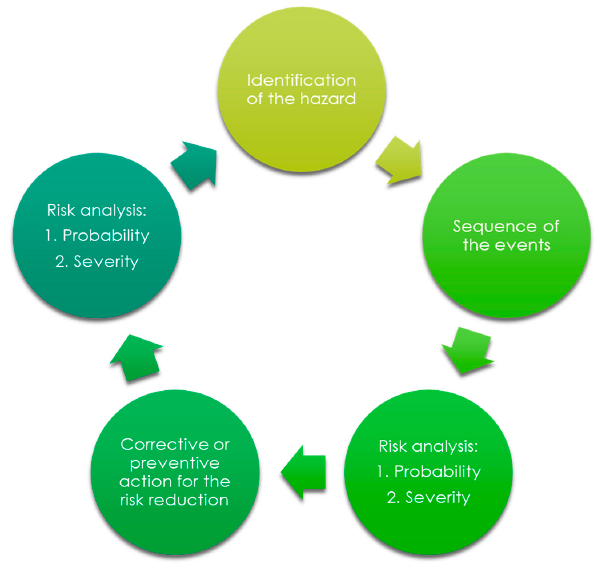
Figure 2. Risk analysis in designing the medical device—usable form of a haemostatic agent.